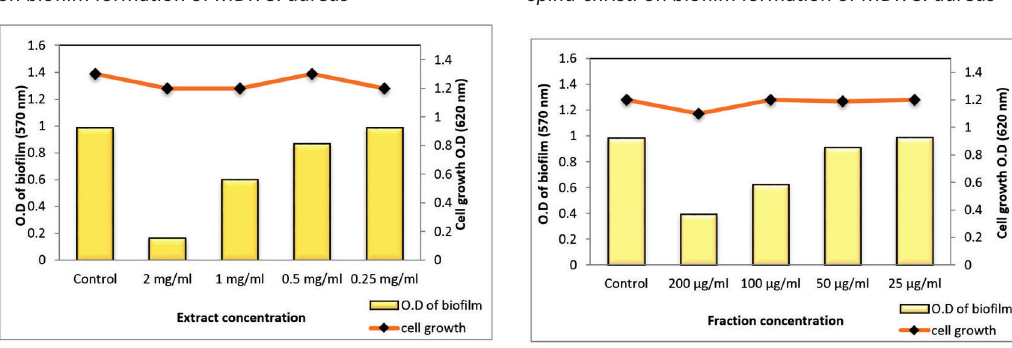
Fig. 8. Effect of sub-MIC of Z. spina-christi total extract on biofilm formation of MDR- S. aureus